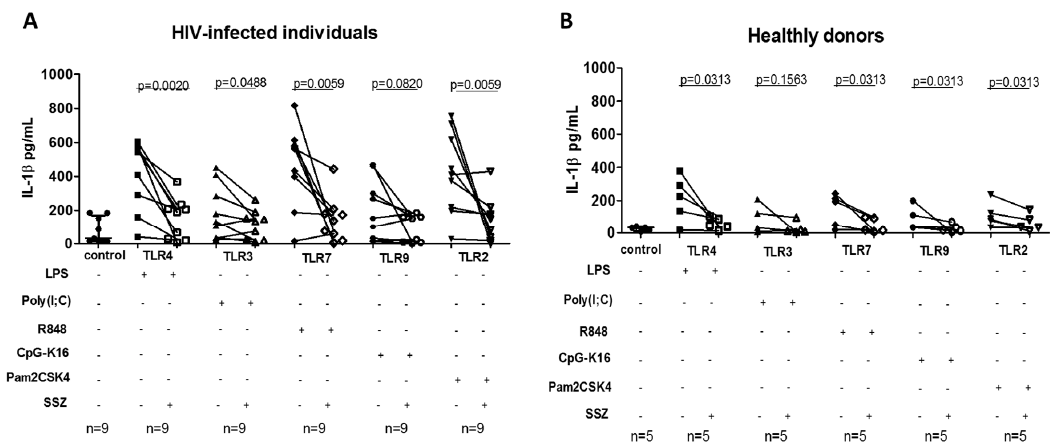
Figure 4. IL-1 β release by peripheral blood mononuclear cells (PBMCs) in response to TLRs agonists and sulfasalazine (SSZ). IL-1 β production by PBMCs from healthy donors ( A ) and people living with HIV ( B ); these cells were treated in vitro with TLR agonist (LPS 100 ng/mL; poly(I:C) 1 μ g/mL; R848 1 μ g/mL; Pam 2 CSK 4 40 ng/mL; and CpG-K16 4 μ g/mL) in the presence of 1 mM SSZ during 18 h of incubation and were quantified by ELISA. Statistical comparison between groups was performed using a Wilcoxon matched-pairs signed rank one-tailed test with a confidence level of 95%. (+: presence, − : absence).